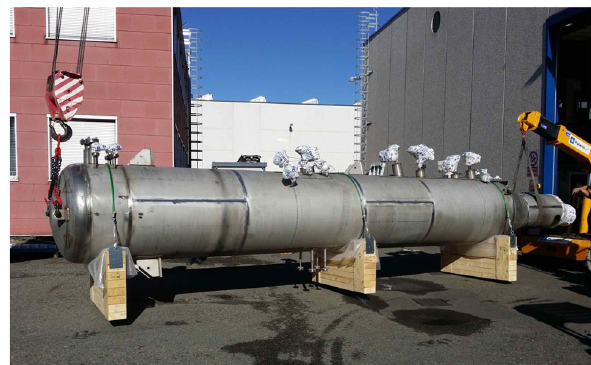
Fig. 4 The top module of the column